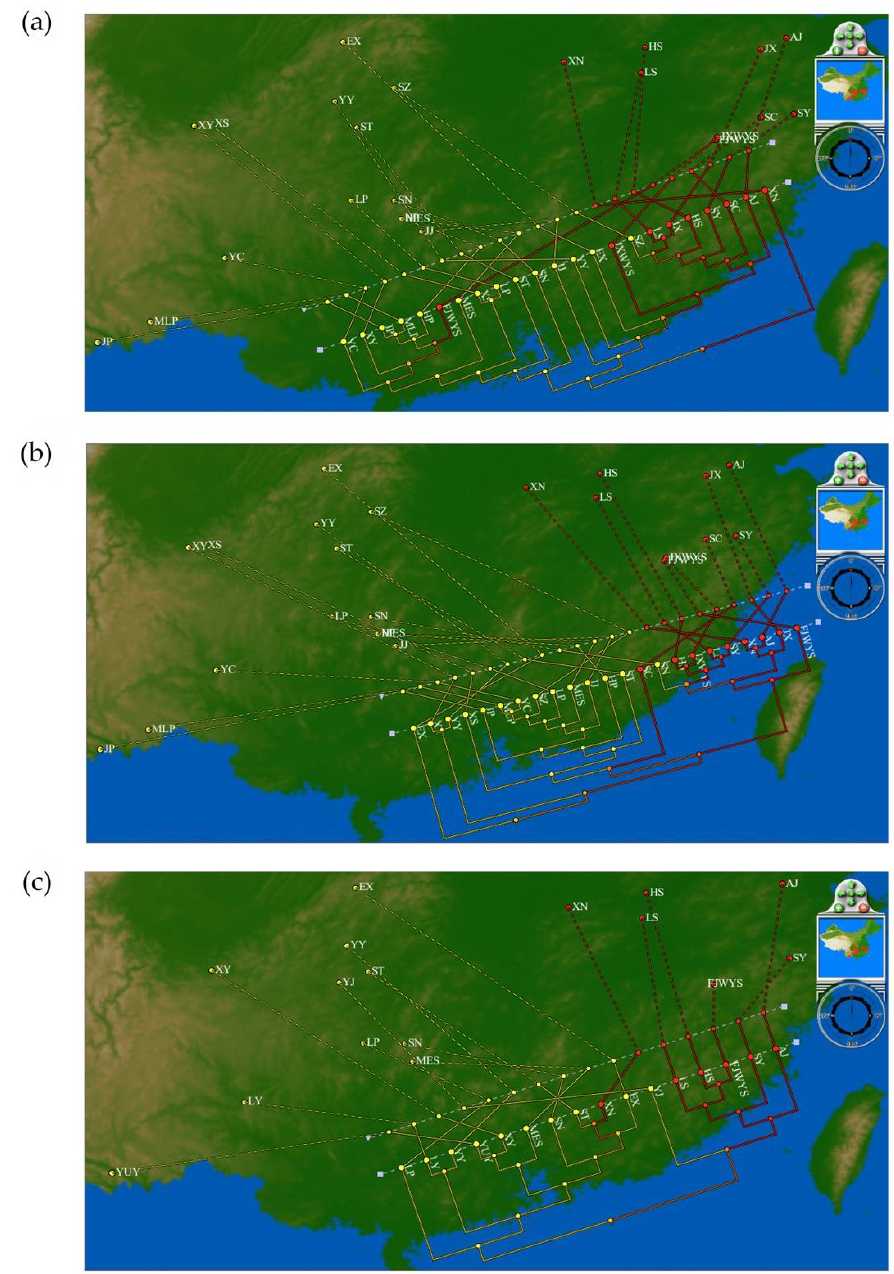
Figure 2. Neighbor-joining (NJ) trees of L. chinense populations. ( a ) NJ trees of L. chinense populations based on cpDNA. ( b ) NJ trees of L. chinense populations based on nuclear ribosomal DNA (nrDNA). ( c ) NJ trees of L. chinense populations based on five nuclear genes. Red dots represent sample locations of eastern populations; yellow dots represent sample locations of western populations. The colors of NJ tree branches indicate sample locations.